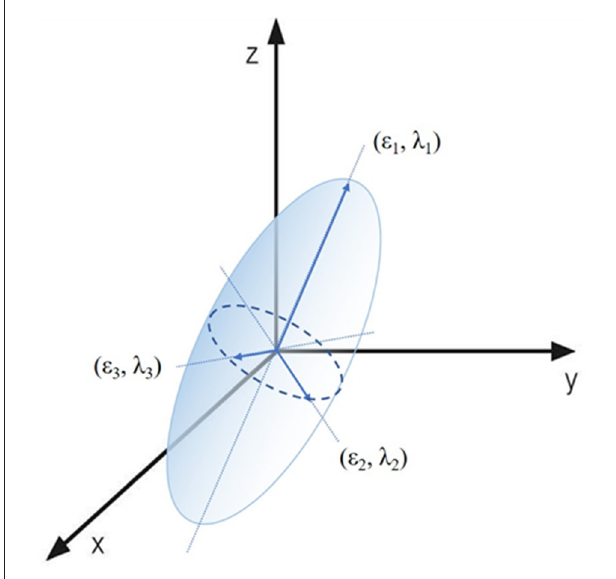
FIGURE 1 | Visual presentation of the diffusion tensor model. The ellipsoid area of a water molecule diffusion can be characterized by three eigenvectors ( ε 1 , ε 2 , ε 3 ) and three eigenvalues ( λ 1 , λ 2 , λ 3